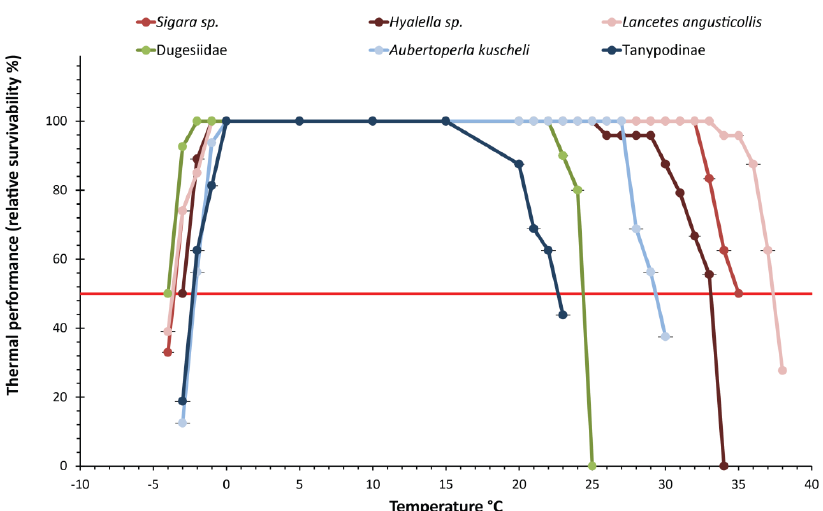
Figure 4. Thermal performance curves ( ± SD) of studied macroinvertebrate taxa. Red-colored lines indicate taxa restricted to low elevation lagoons, the green-colored line indicate taxa at a medium elevation, and blue-colored lines represent taxa restricted to high elevation lagoons from the Róbalo watershed, Navarino Island, southern Chile. The red line at 50% relative survival denotes CT 50 . Table 2. CT max , CT min , and thermal breadth values of the studied macroinvertebrate taxa, ( ± SD). Values are given in °C.